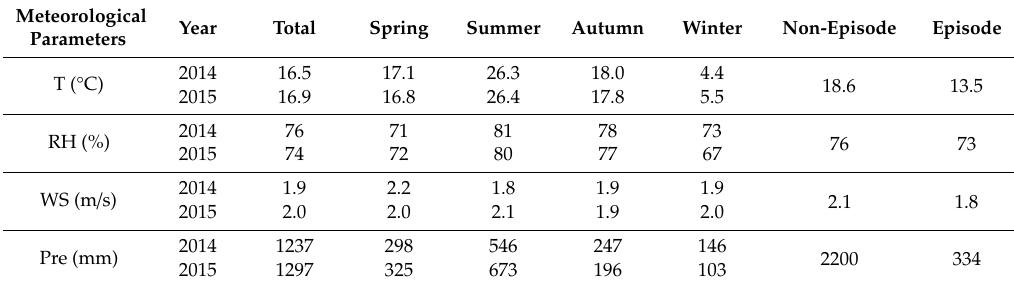
Table 2. Statistics of general meteorological parameters at Hefei *.